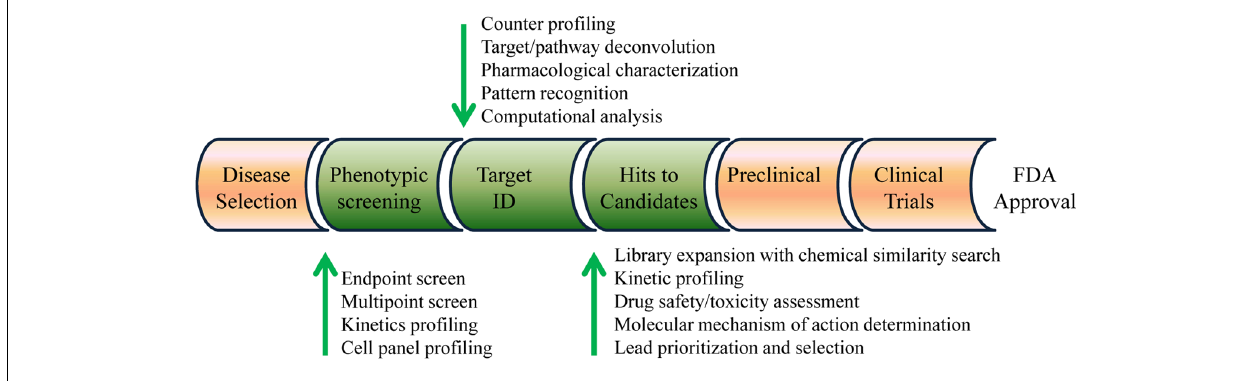
FIGURE 1 | Label-free drug discovery strategy. Combining computational approaches with label-free cell phenotypic profiling and screening techniques can be used for high-throughput screening, target engagement